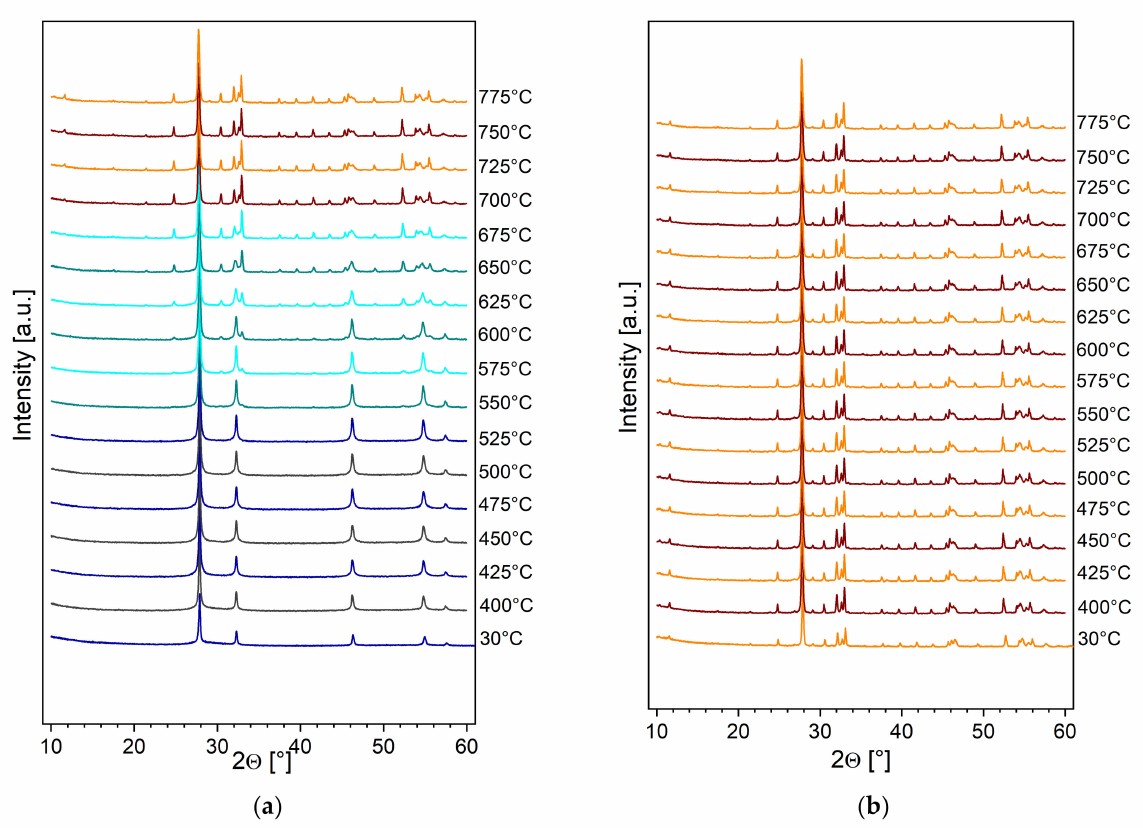
Figure A1. ( a ) Thermal evolution of XRD patterns of a sample prepared in ceramic crucible at 1000 ◦ C and quenched by twin rollers method (800 RPM) during heating up to 775 ◦ C. ( b ) Thermal evolution of the same sample during cooling down from 775 ◦ C to room temperature. Blue and gray colors correspond to δ -like phase (fluorite structure); turquoise color indicates phase transition to γ -like phase; orange and maroon colors correspond to γ -like phase stability